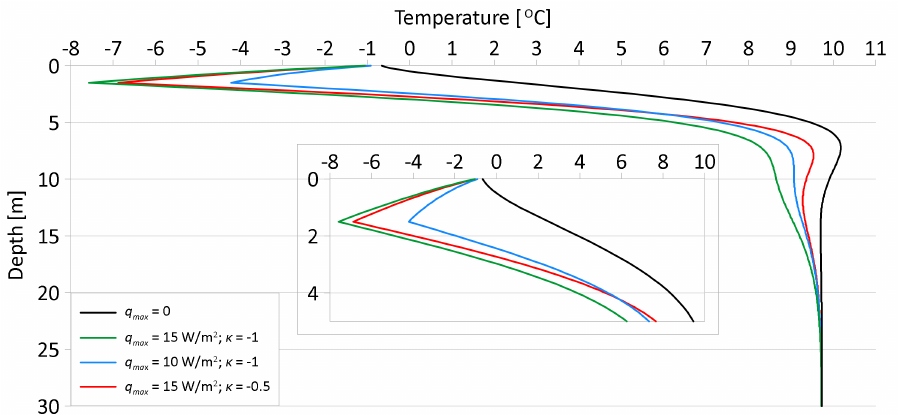
Figure 4. Ground temperature profiles on February 15th for various conditions of heat extraction from the ground; k = 1.4 W/ ( mK )